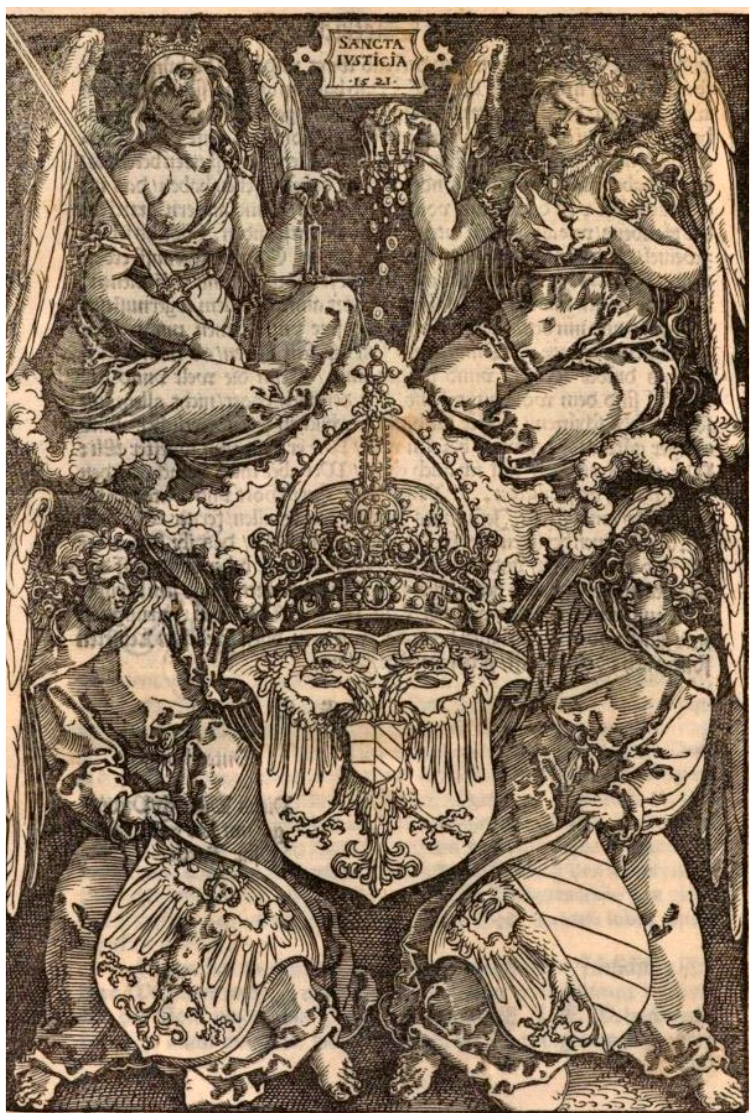
Figure 14. Albrecht Dürer, Sancta Iusticia , woodcut, 1521. in (Luther 1544b, fol. [vi]v) (Munich, Bayerische Staatsbibliothek, 2 Hom. 277, urn:nbn:de:bvb:12-bsb10144039-2; NoC-NC/1.0).